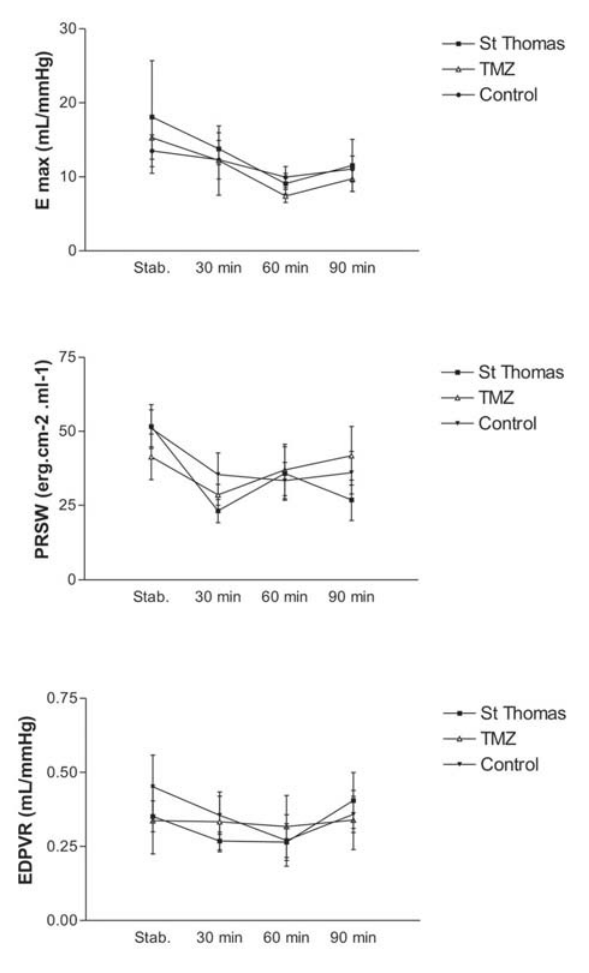
Fig. 4 - Índices de contratilidade. Elastância máxina (acima), PRSW (médio), “rigidez” ou “dureza” do ventrículo (EDPVR) (abaixo) dos corações isolados. Medidas de estabilização e aos 30, 60 e 90 minutos de reperfusão em modo “working heart” após períodos de isquemia regional e global. Dados apresentados como média e dois erros padrão da média (EPM) (n = 6) em cada